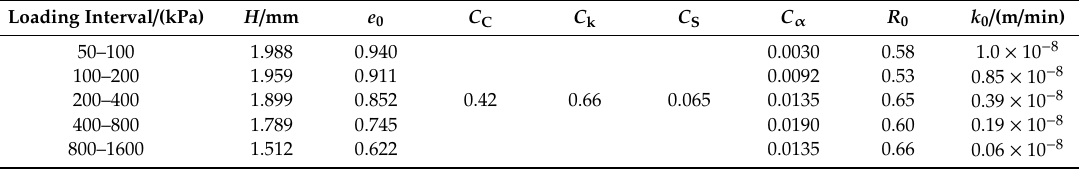
Table 7. UH model parameters of sample